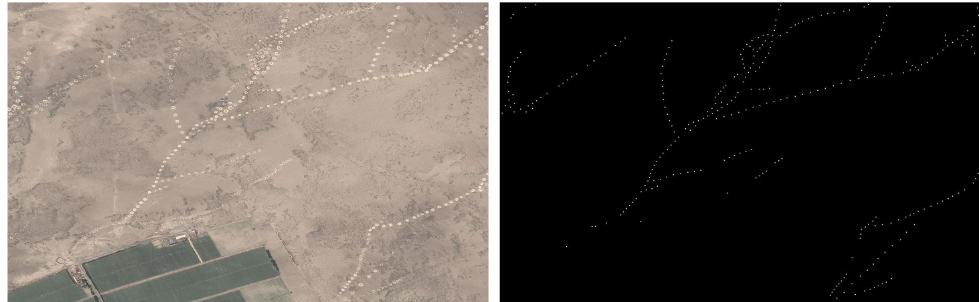
Figure 8. Original image is shown on the left, and the karez map predicted by YOLOv5 on the right is a binary mask